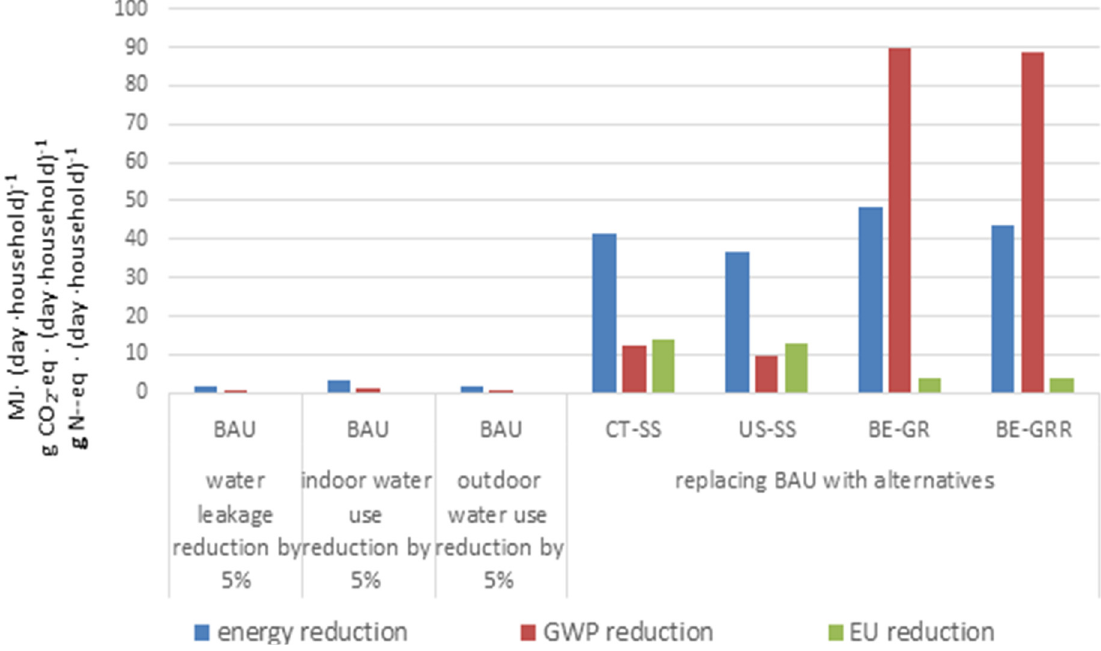
Figure 6. The reduction of life cycle energy consumption, global warming and eutrophication potentials through multiple measures. The units of energy reduction, global warming potential reduction, and eutrophication potential reduction are MJ·(household·day) − 1 , gCO 2 -eq·(household·day) − 1 , and g N-eq·(household·day) − 1 , respectively.